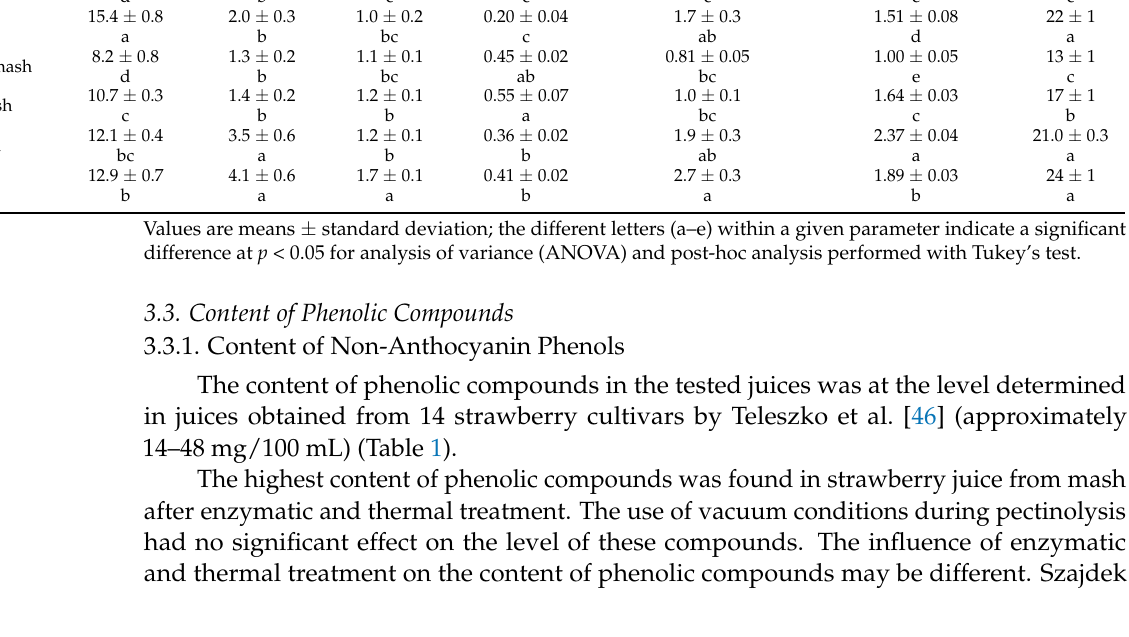
Table 1. Effect mash treatment on the content of non-anthocyanin phenolic compounds (mg/100 g f. w.).